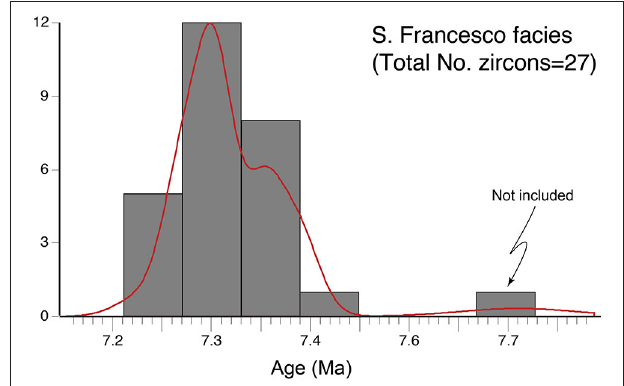
FIGURE 9 | Distribution of zircon age population for the S. Francesco facies of the Mt. Capanne pluton from Barboni et al. (2015).